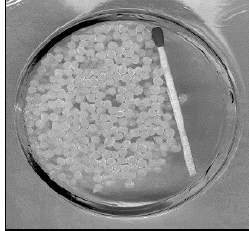
Figure 2. The overall view of chitosan beads